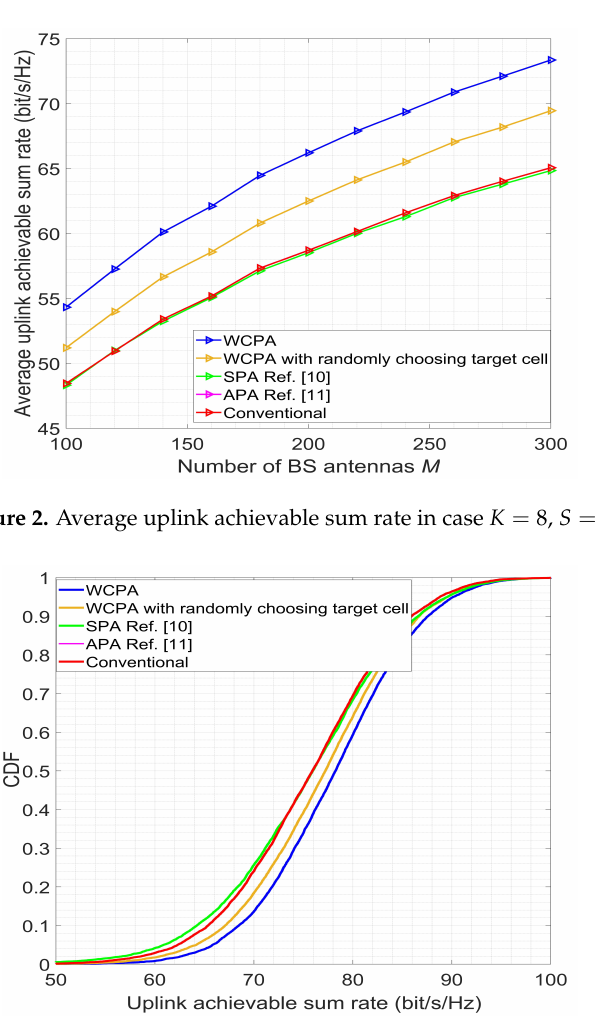
Figure 3. CDF of uplink achievable sum rate in case K = 8, S =